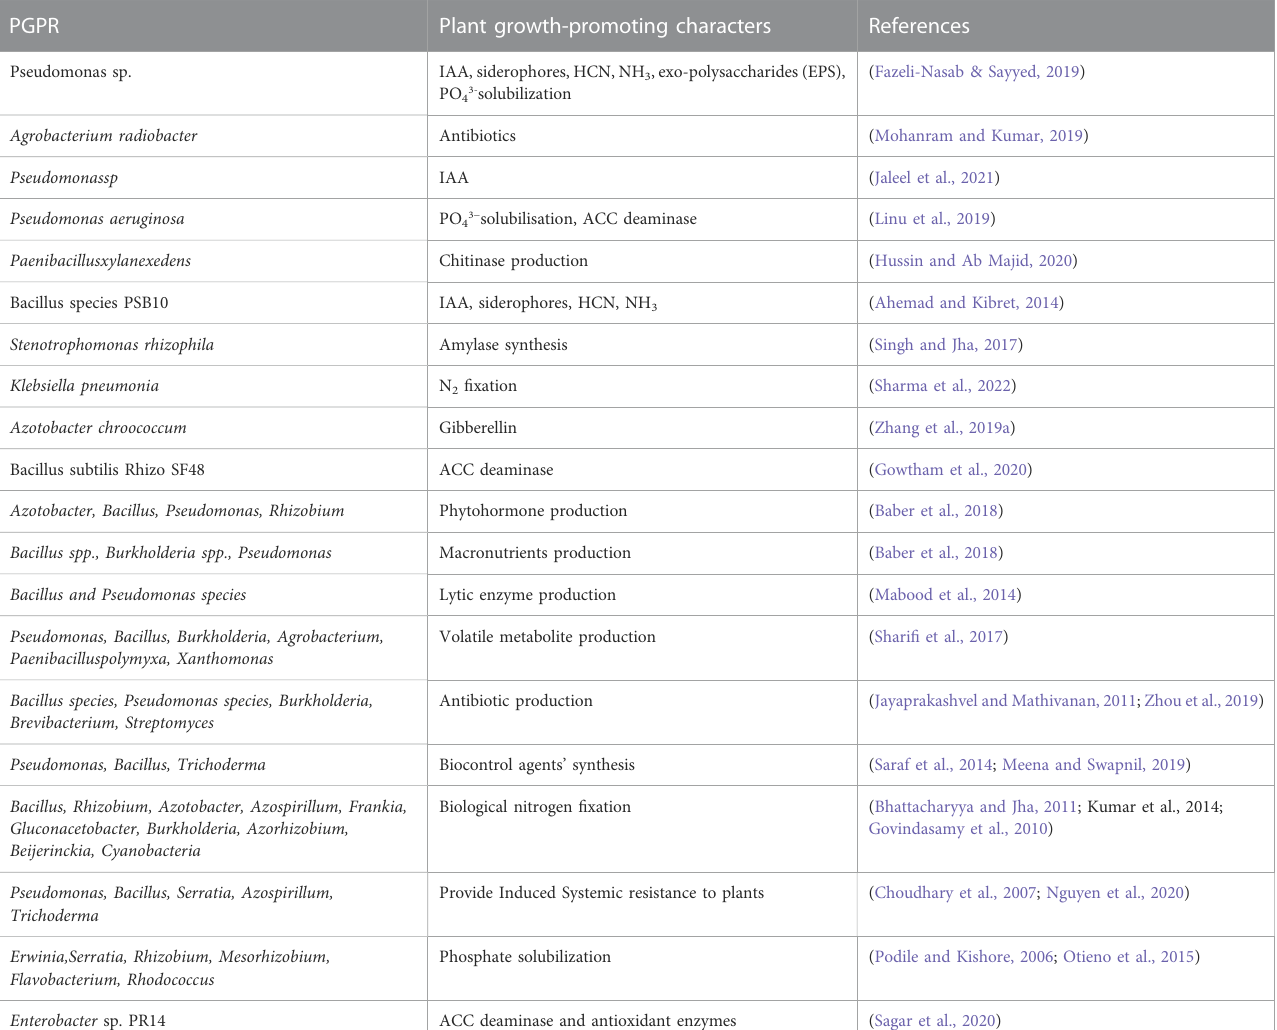
TABLE 1 Growth-promoting substances released by